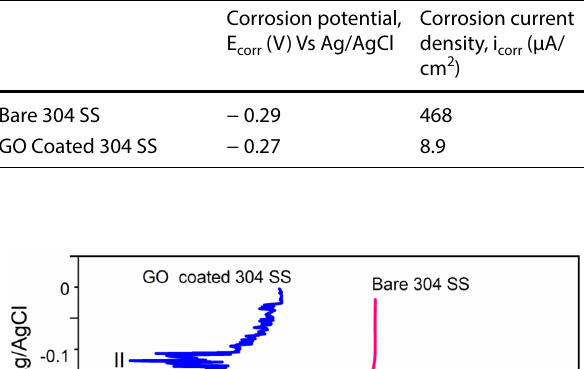
Corrosion potential, E (V) Vs Ag/AgCl corr